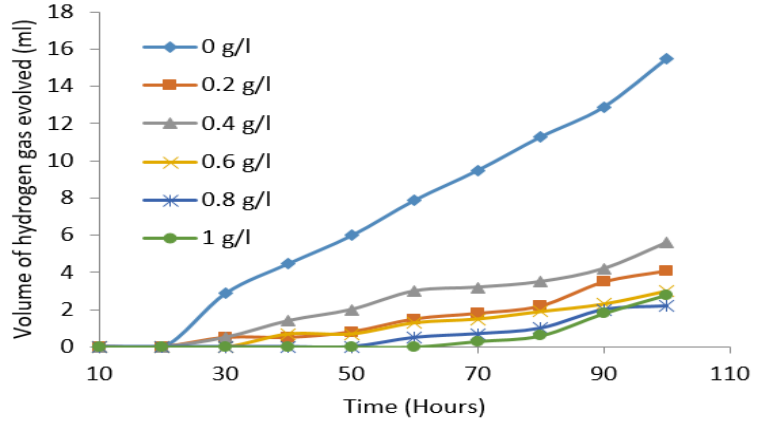
Figure 12: Rate of evolution of hydrogen gas in 1M HCl at different concentration of the